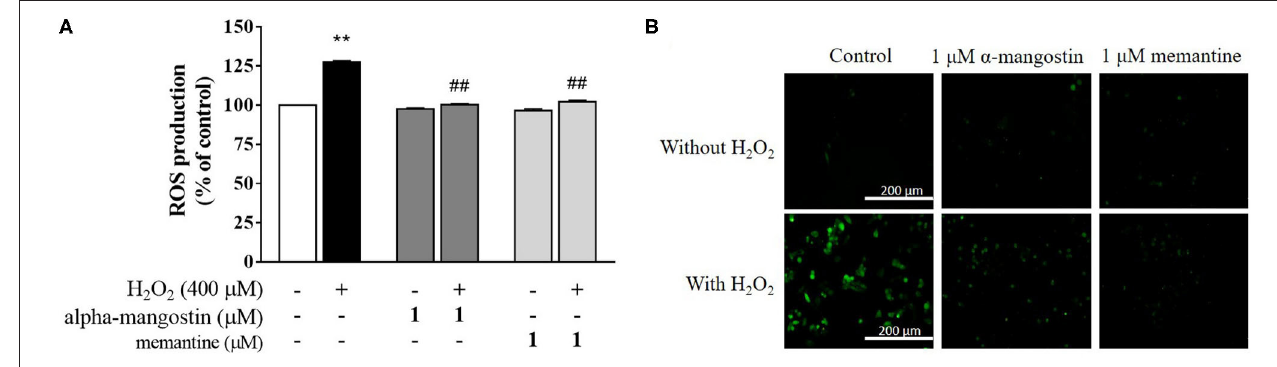
FIGURE 5 | alpha-Mangostin decreased H 2 O 2 -induced ROS generation. (A) Cells were pretreated with/without 1 µ M alpha-mangostin and memantine for 3h prior to H 2 O 2 treatment. The intracellular ROS levels were determined by H 2 DCFDA assay. (B) Representative fluorescence microscopy image of the cells stained with H 2 DCFDA was observed by fluorescence microscope. Scale bars = 200 µ m. Data are presented as mean ± SEM of four independent experiments. ** P < 0.01 vs. control and ## P < 0.01 vs. H 2 O 2 .